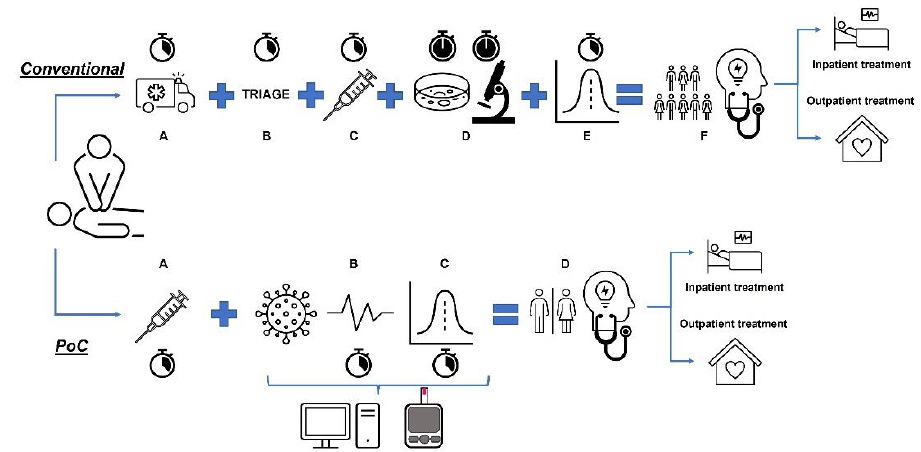
Figure 1. A schematic representation of the resources needed to achieve a diagnosis: PoC versus Conventional Procedure. On the top, the Conventional option shows the process until getting a diagnostic in the conventional procedure (i.e., Transfer hospital [A] + Triage [B] + Sample Collection [C] + Sample processing in the lab [D] + Results [E]) to make the diagnosis, and to indicate the treatment at home, or in the hospital (i.e., Analysis medical staff [F]). At the bottom, the PoC option confirms the reduction of the process: Sample Collection (A) + Analyze results PoC (B)+ Results (C: in a few minutes), to get a diagnostic with the use of PoC (D).